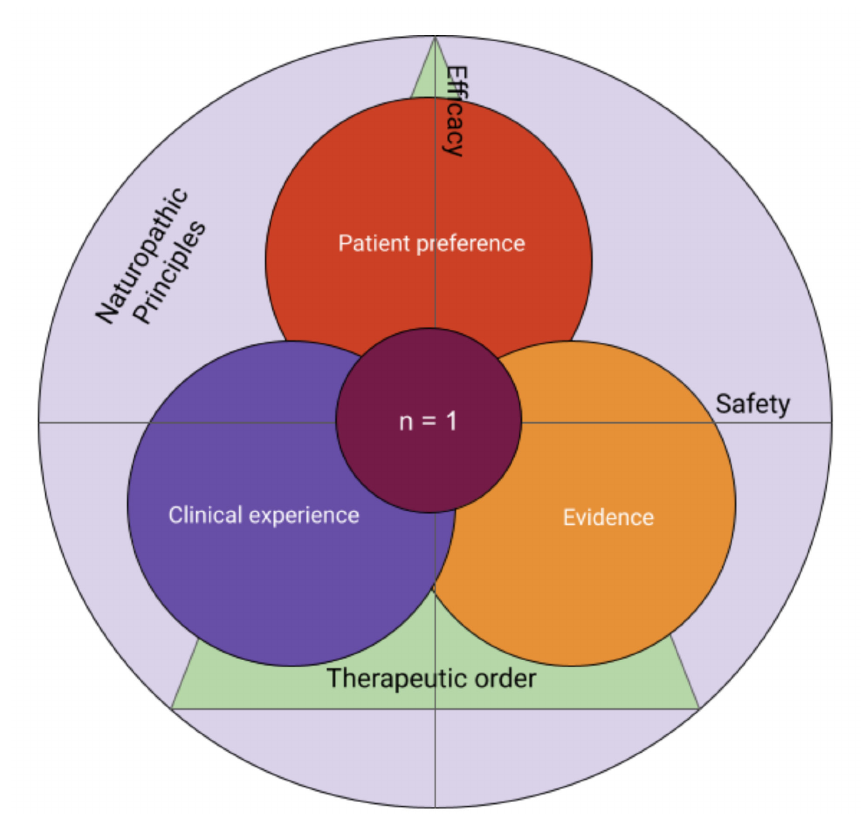
Figure 4. Evidence informed practice considers the available evidence for safety and efficacy, reflective clinical experience, and the values and preferences of the patient or family in order to inform consent, ultimately leading to an “n-of-1”